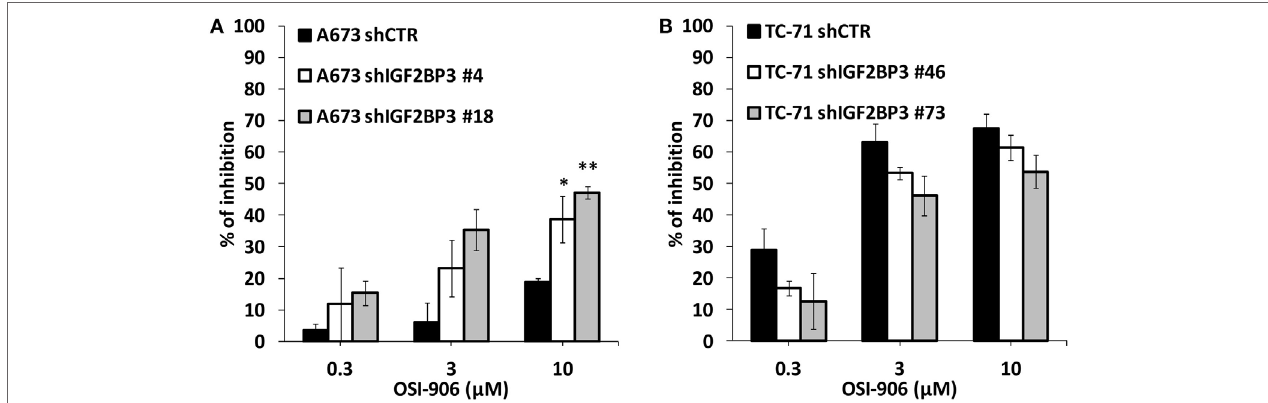
FigUre 5 | Efficacy of agents blocking the IGF system in insulin-like growth factor 2 mRNA-binding protein 3 (IGF2BP3)-depleted models. Cell growth was assessed using the MTT assay after 72 h of exposure to OSI-906 at indicated doses in IGF2BP3-depleted or empty vector-transfected (shCTR) A673 (a) and TC-71 (B) Ewing sarcoma cells. Results are displayed as the percentage of growth inhibition relative to that in untreated control cells. Histograms represent the mean of three independent experiments, in which each sample was in triplicate, and bars represent the SE. * p < 0.05, ** p < 0.01, one-way ANOVA compared with